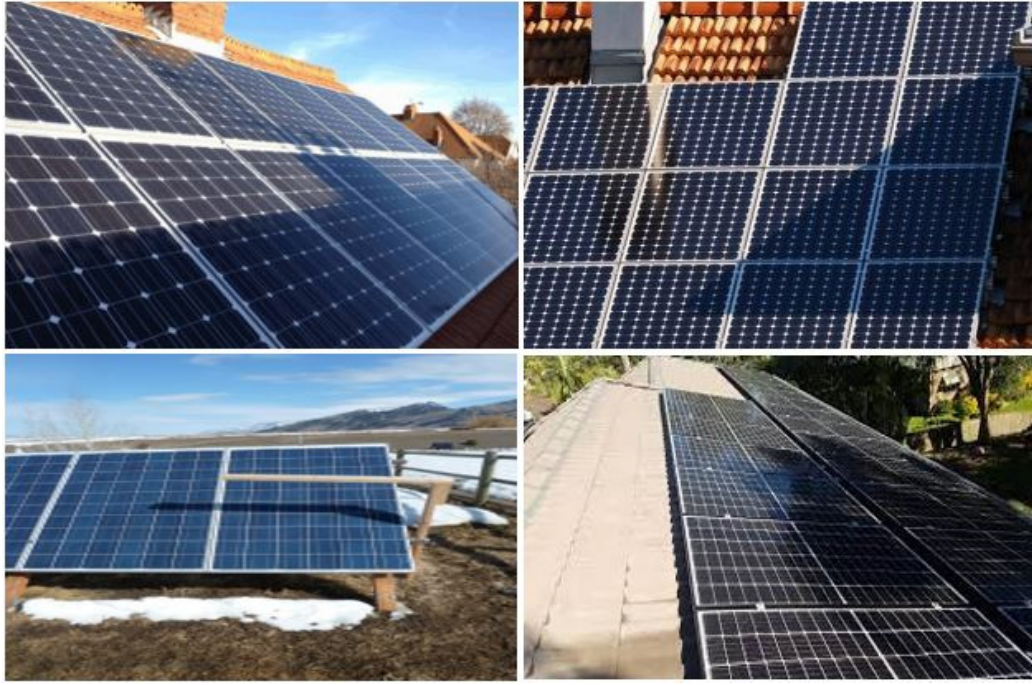
Figure 23. Different shadows on PV panels.